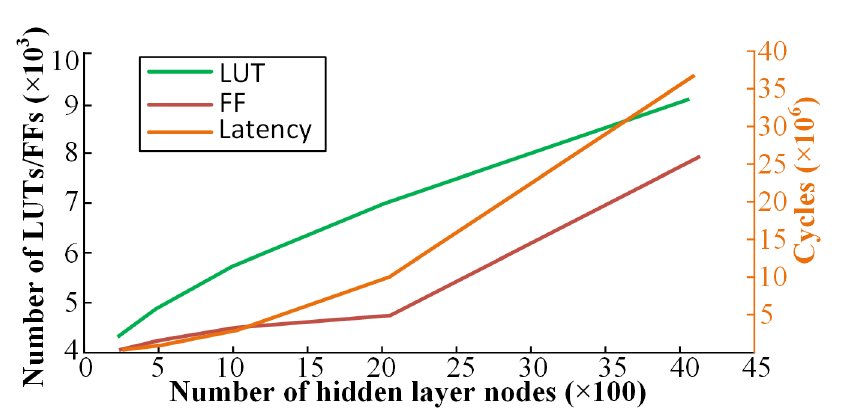
Figure 17: The variation of the number of LUTs, FFs and inference latency with the number of increasing nodes in the hidden layer for the MLP hardware